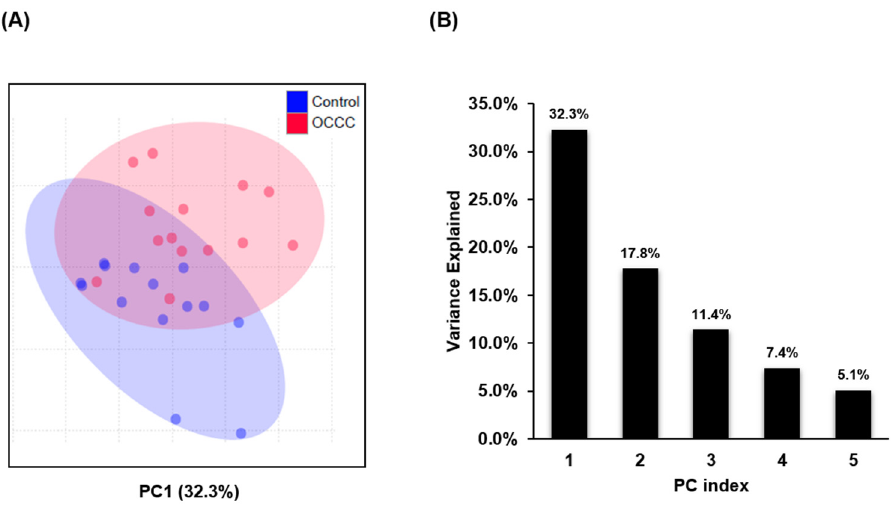
Figure 1. Overview of comparative lipidomic analysis of OCCC vs. control samples: ( A ) PCA analysis showing the group variance, PC1 explained 32.3% of variance, circles represent 95% confidence regions. ( B ) Individual variance contributed by the top 5 principal components.